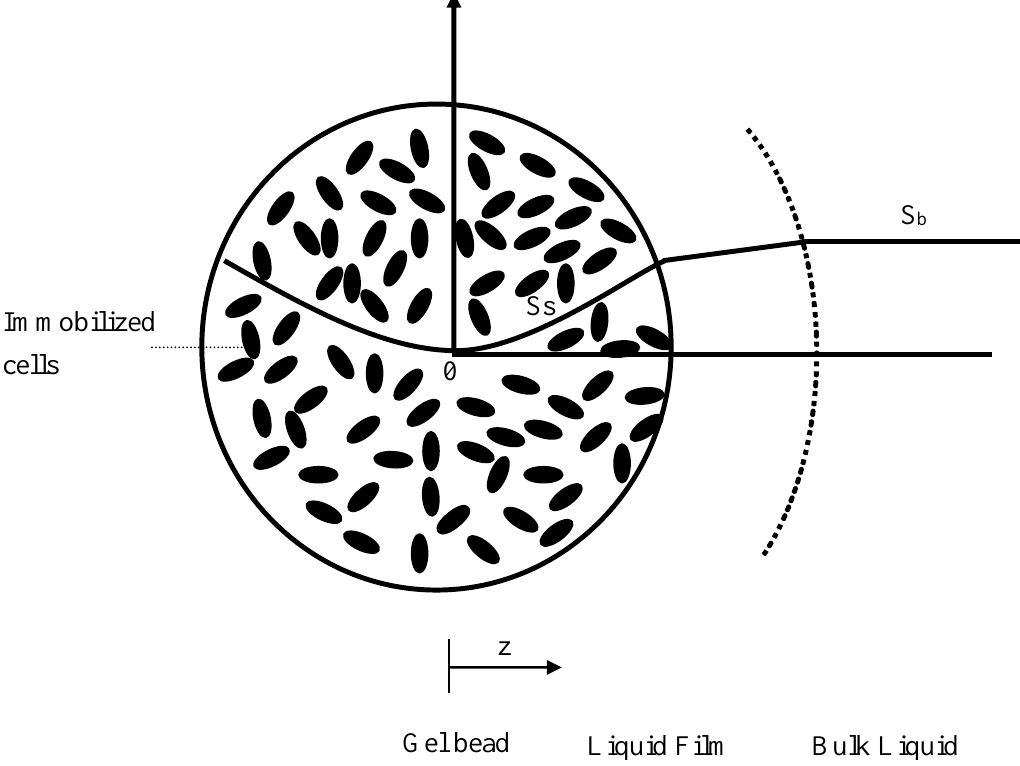
Figure 1. Concentration profile of phenol in an immobilized cell system.